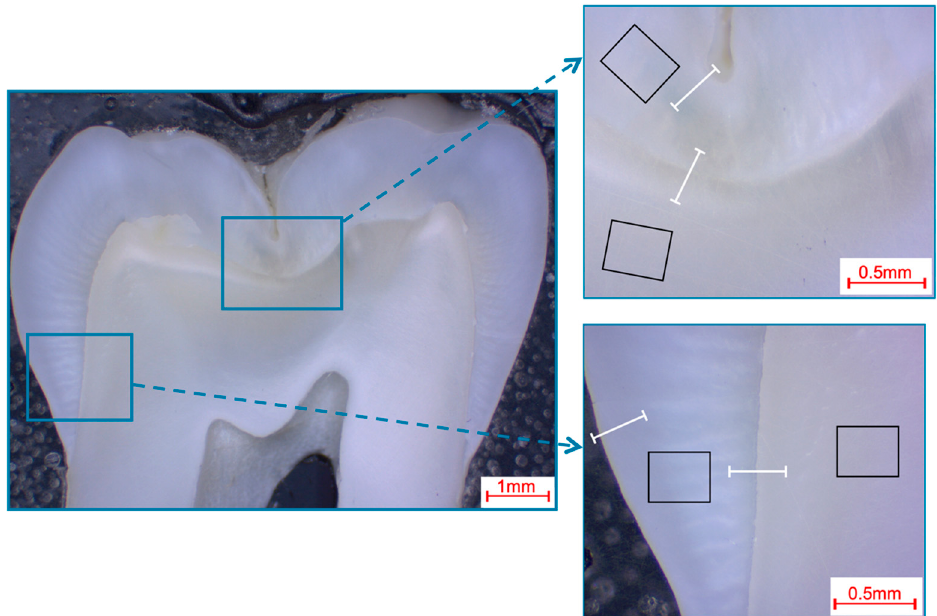
Figure 4. Selection of fields and line scans for the elemental analysis in human third molars shown in a photo-microscopic overview. The black rectangles indicate the areas of the 366 µ m × 291 µ m field scans, while the white lines indicate the approximately 360 µ m paths of the line scans. The upper right picture shows the fissure area, while the bottom right picture shows the approximal area.